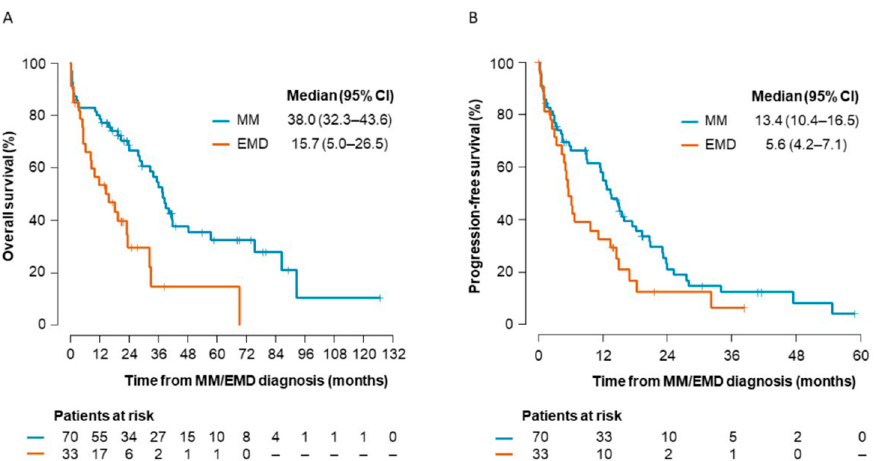
Figure 5. Overall survival and progression-free survival of multiple myeloma (MM) and ex- tramedullary myeloma (EMD) patients. ( A ) MM patients had significantly longer overall survival compared to EMD patients ( p < 0.001). ( B ) MM patients had significantly longer progression-free survival compared to EMD patients ( p = 0.051).